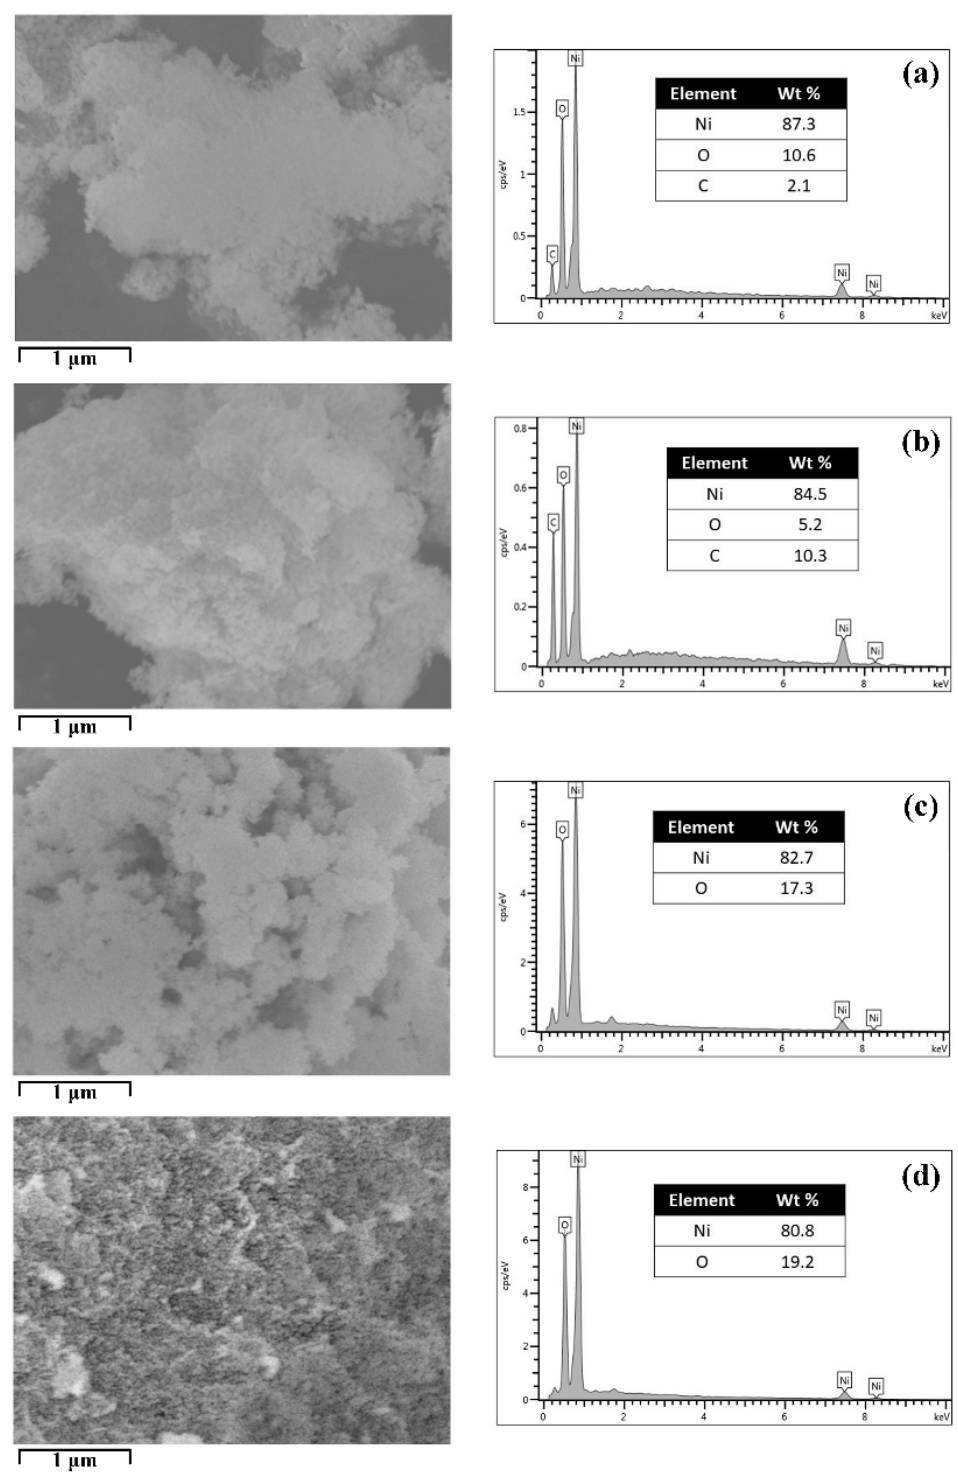
Figure 4. EDX spectrum of ( a ) NaOH-, ( b ) aloe-vera-, ( c ) dragon-fruit- and ( d ) papaya-extract-mediated NiO x nanoparticles.